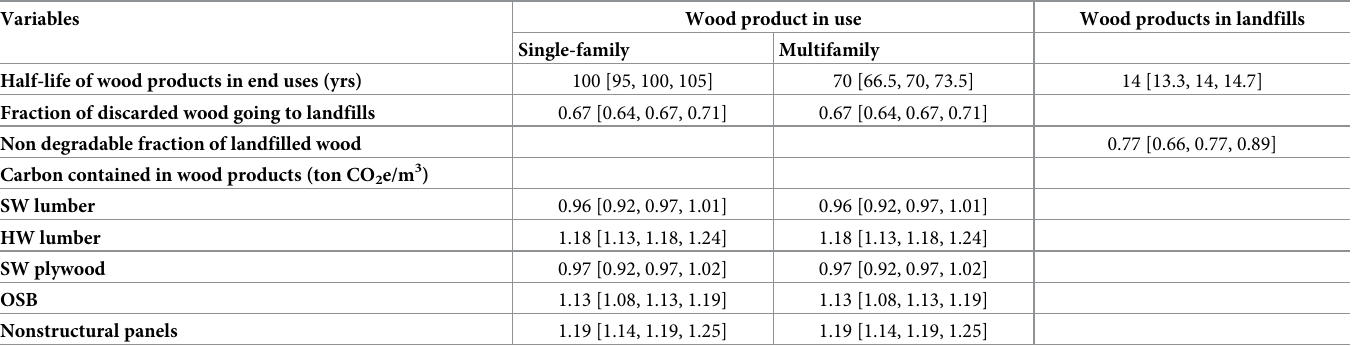
Table 3. Data and conversion factors used to calculate carbon stored in wood product in use in residential units and in landfills after demolition (source: [34]) 1 .